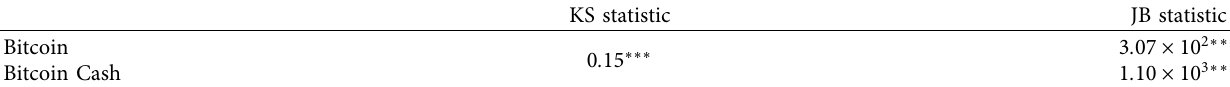
Table 2: Comparison between the two samples: Bitcoin and Bitcoin Cash.